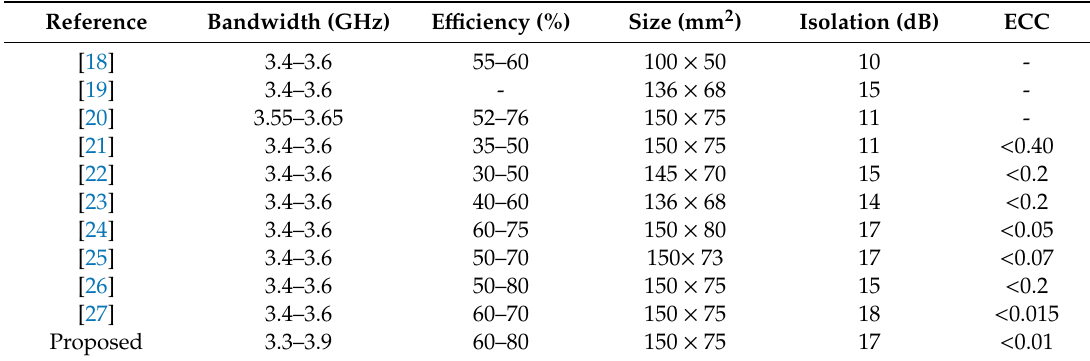
Table 2. Comparison between the presented and recently reported 5G mobile-phone antennas.